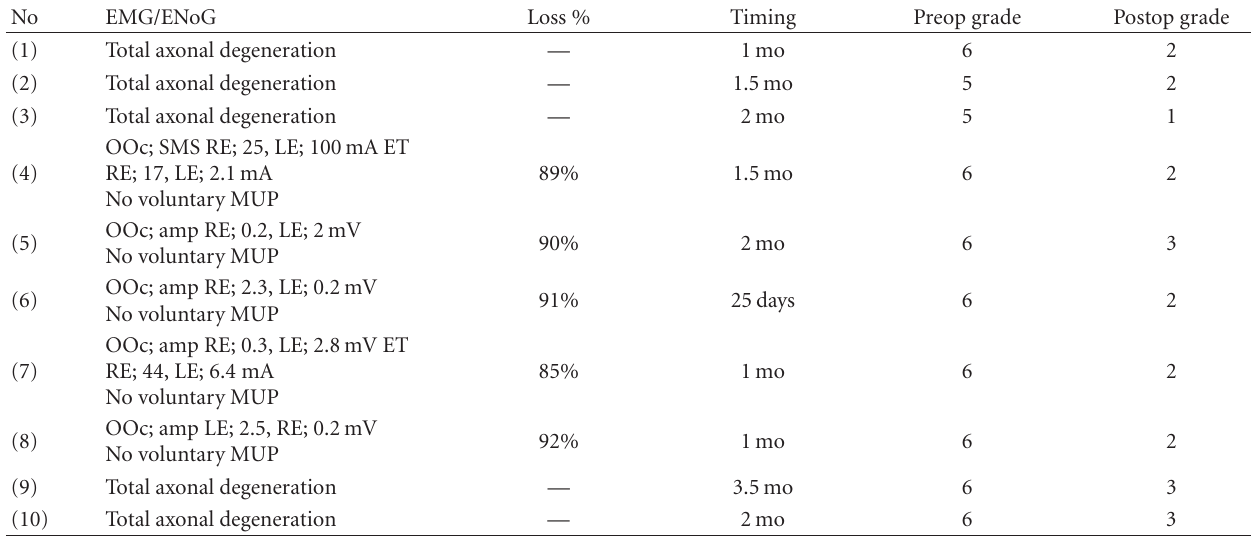
Table 2: Electrophysiology, surgical timing and the results of facial decompression (Mo: month, OOc: orbicularis oculi, mV: microvolt, mA: milliampere, SMS: supramaximal stimulation, amp: amplitude, ET: excitation threshold, RE: right ear, LE: left ear, and MUP: motor unite